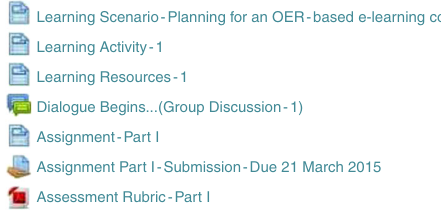
Figure 1. A sample module